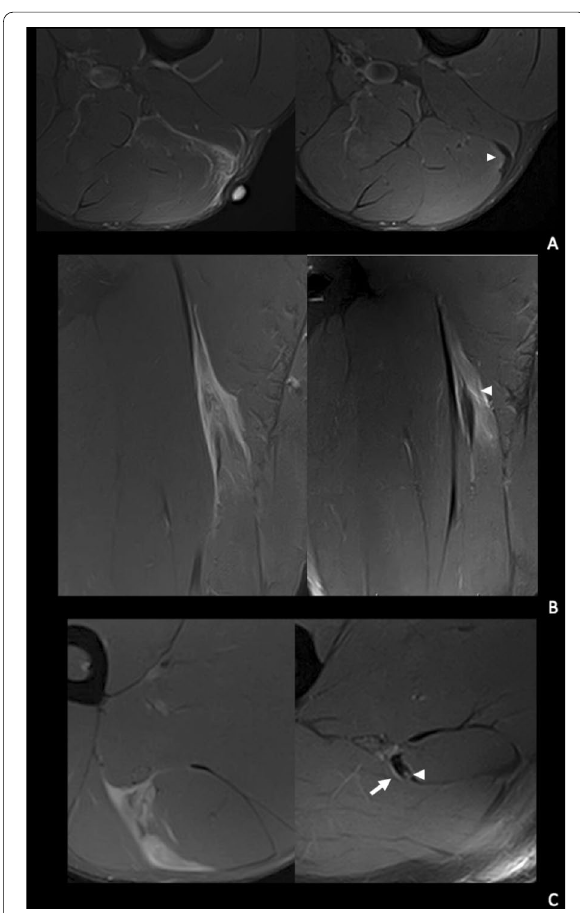
Fig. 4 Spectrum of findings related to risk of reinjury. A A 31‑year‑old right leg dominant futsal player. Axial T2‑weighted fat‑saturated images shows: from a baseline MRI (left) a distal myotendinous injury of the left biceps femoris long head, I D d 3 r 0 (left). In the pre‑RTP image (right) we can see a mature scar and a mild adaptive oedema (arrowhead). No signs associated with a higher reinjury risk.